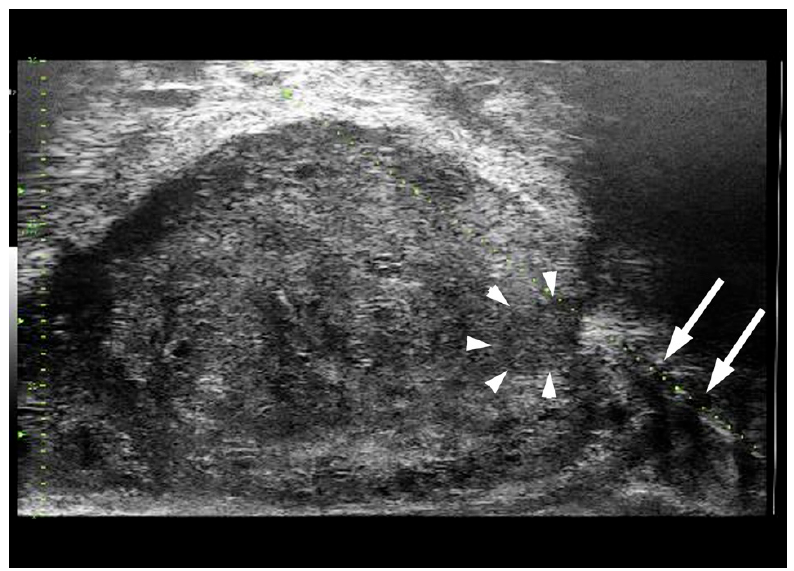
Figure 1. PRIMUS 4 nodule (arrowheads) identified in the apical peripheral zone on microUS with the biopsy needle (arrows). Real time visualization of the nodule allows accurate targeting without MRI/microsUS fusion.